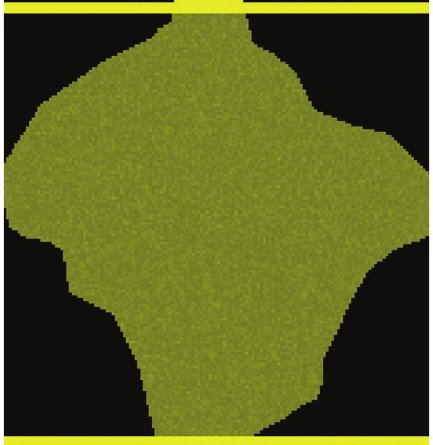
Figure 2: The numerical sample model of ore (generated by RFPA).